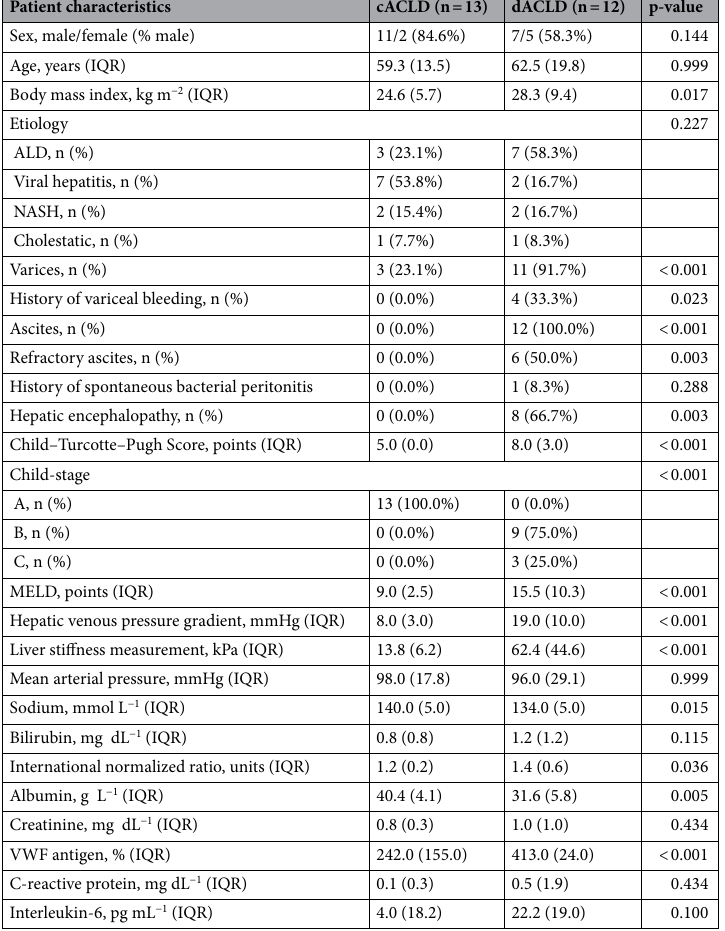
Table 1. Patient characteristics of patients with compensated (cACLD) and decompensated cirrhosis (dACLD). cACLD compensated advanced chronic liver disease, ALD alcoholic liver disease, dACLD decompensated advanced chronic liver disease, IQR interquartile range, MELD model for end-stage liver disease, NASH non-alcoholic steatohepatitis, VWF von Willebrand factor.